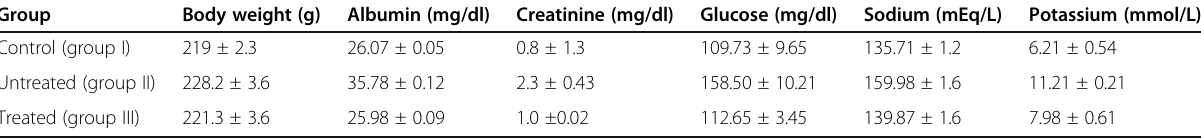
Table 3 Assessment of bodyweight and biochemical studies for control, untreated, and treated groups (mean ± SD, n = 3)